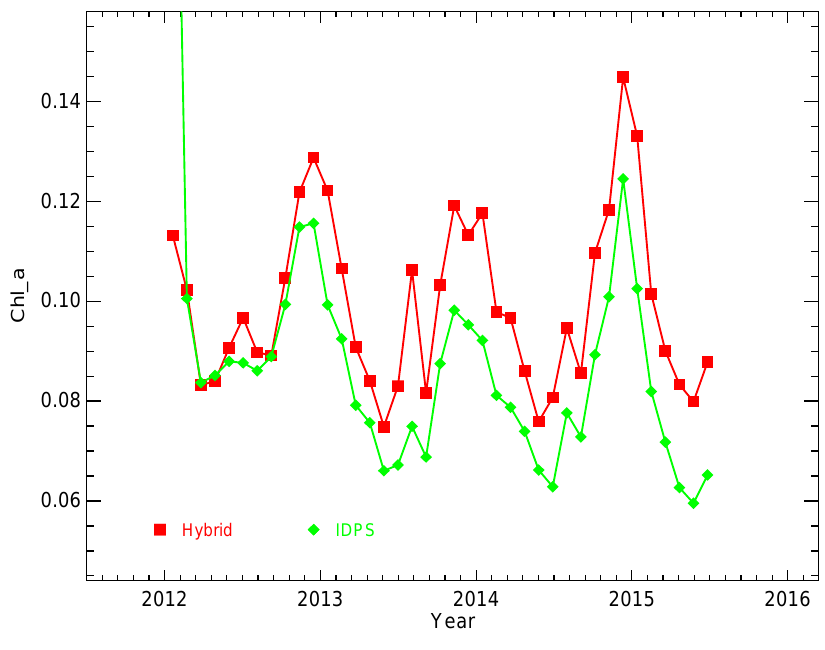
Figure 17. Ocean Chl-a trending.